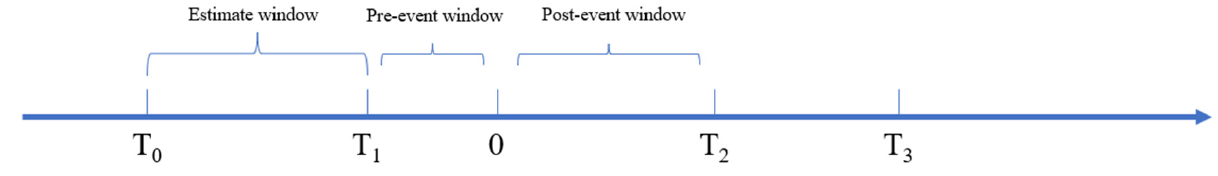
Figure 1. Event study method.